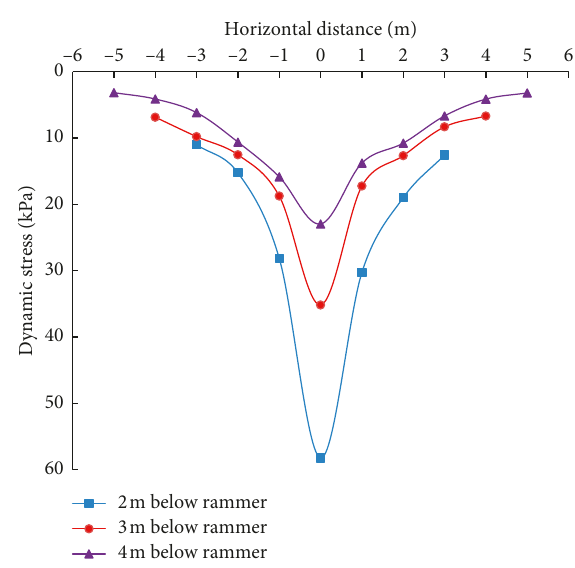
Figure 4: The distribution of the dynamic